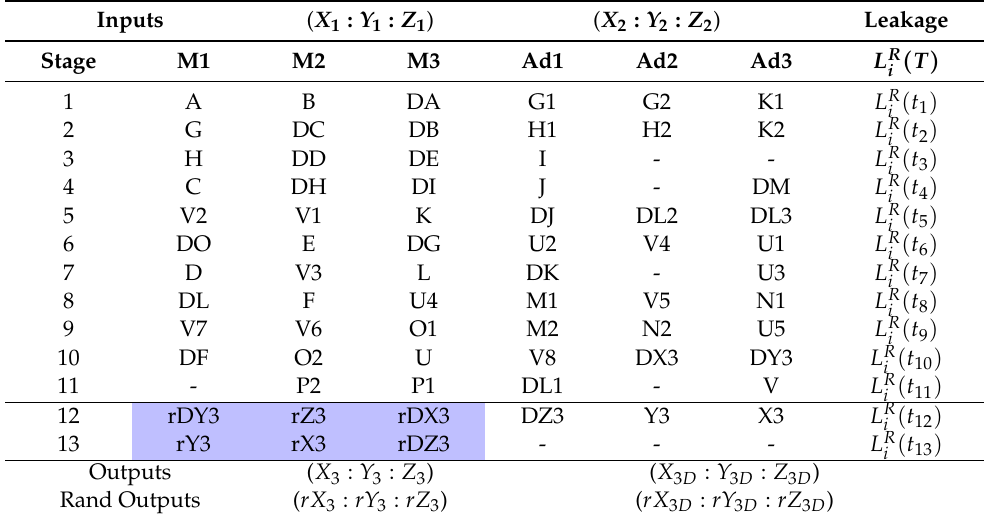
Table 2. Paralleling BEC point addition and doubling GF ( 2 k ) operations on the i th MPL Round ( v = 6 and z = 11 or z =